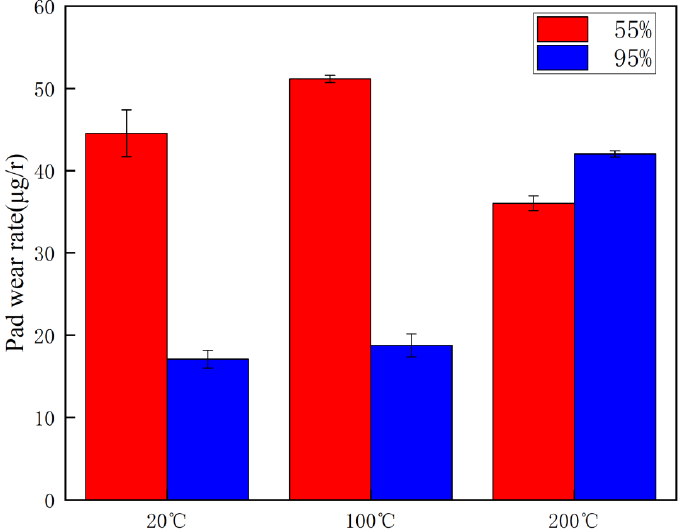
Figure 10. Graph of disk wear rate at different temperatures and ambient humidity.